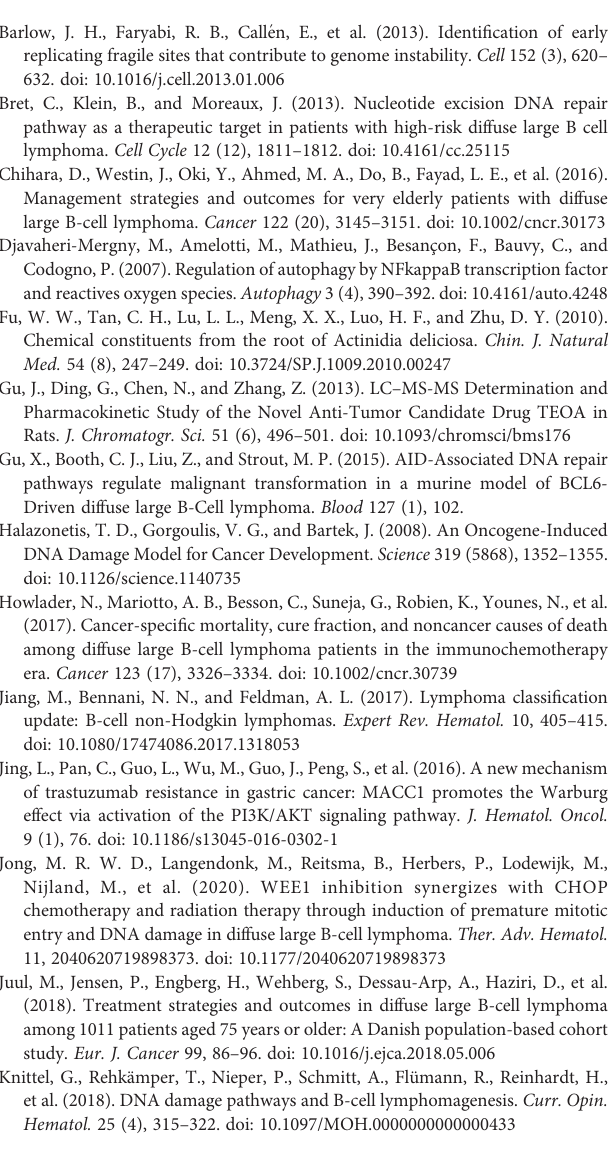
FIGURE S1 | TEOA reduced DLBCL cell viability and arrest the cell cycle. (A) Mouse embryonic fi broblast and immortalized lymphocyte cells were treated with TEOA at indicated concentrations for 12h, cell viability was detected by CCK8 assays. (B, C) The quanti fi cation of PI positive cells in fi g.1E. (D) Flow cytometry